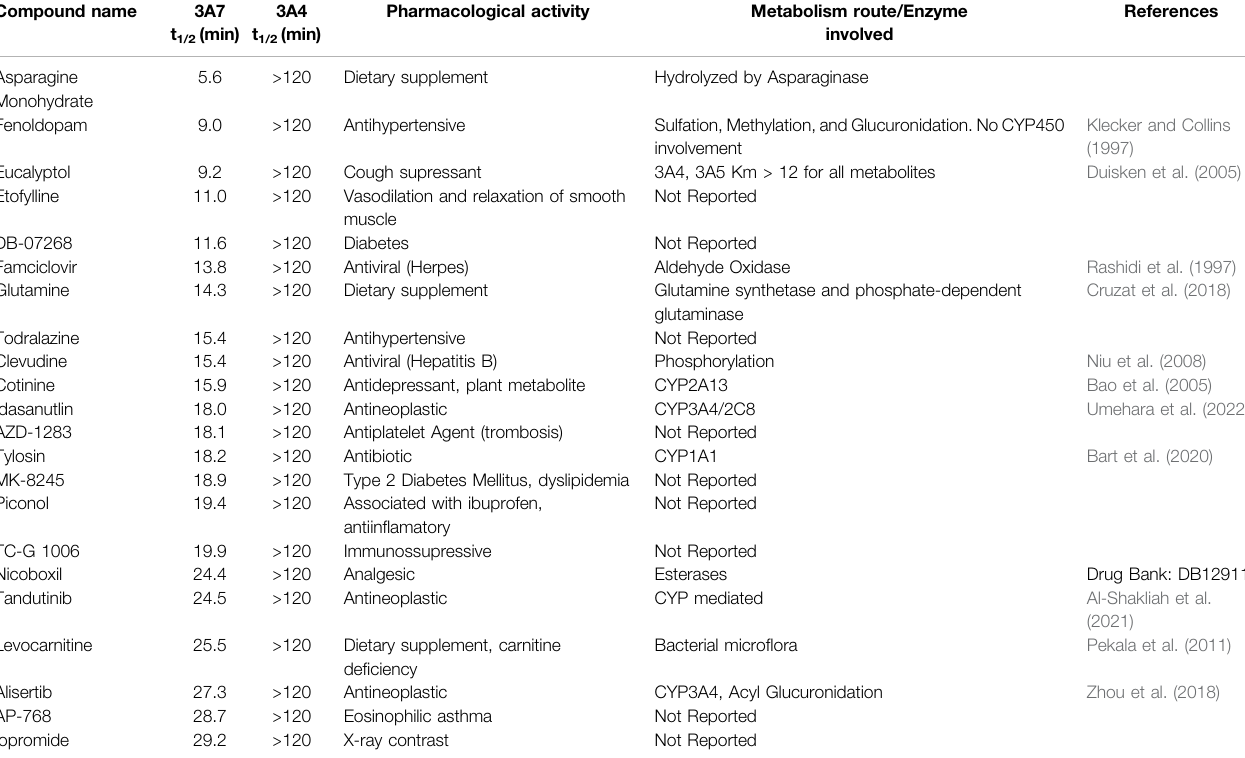
TABLE 3 | List of CYP3A7-selective substrates compared to CYP3A4 based on t 1/2 in